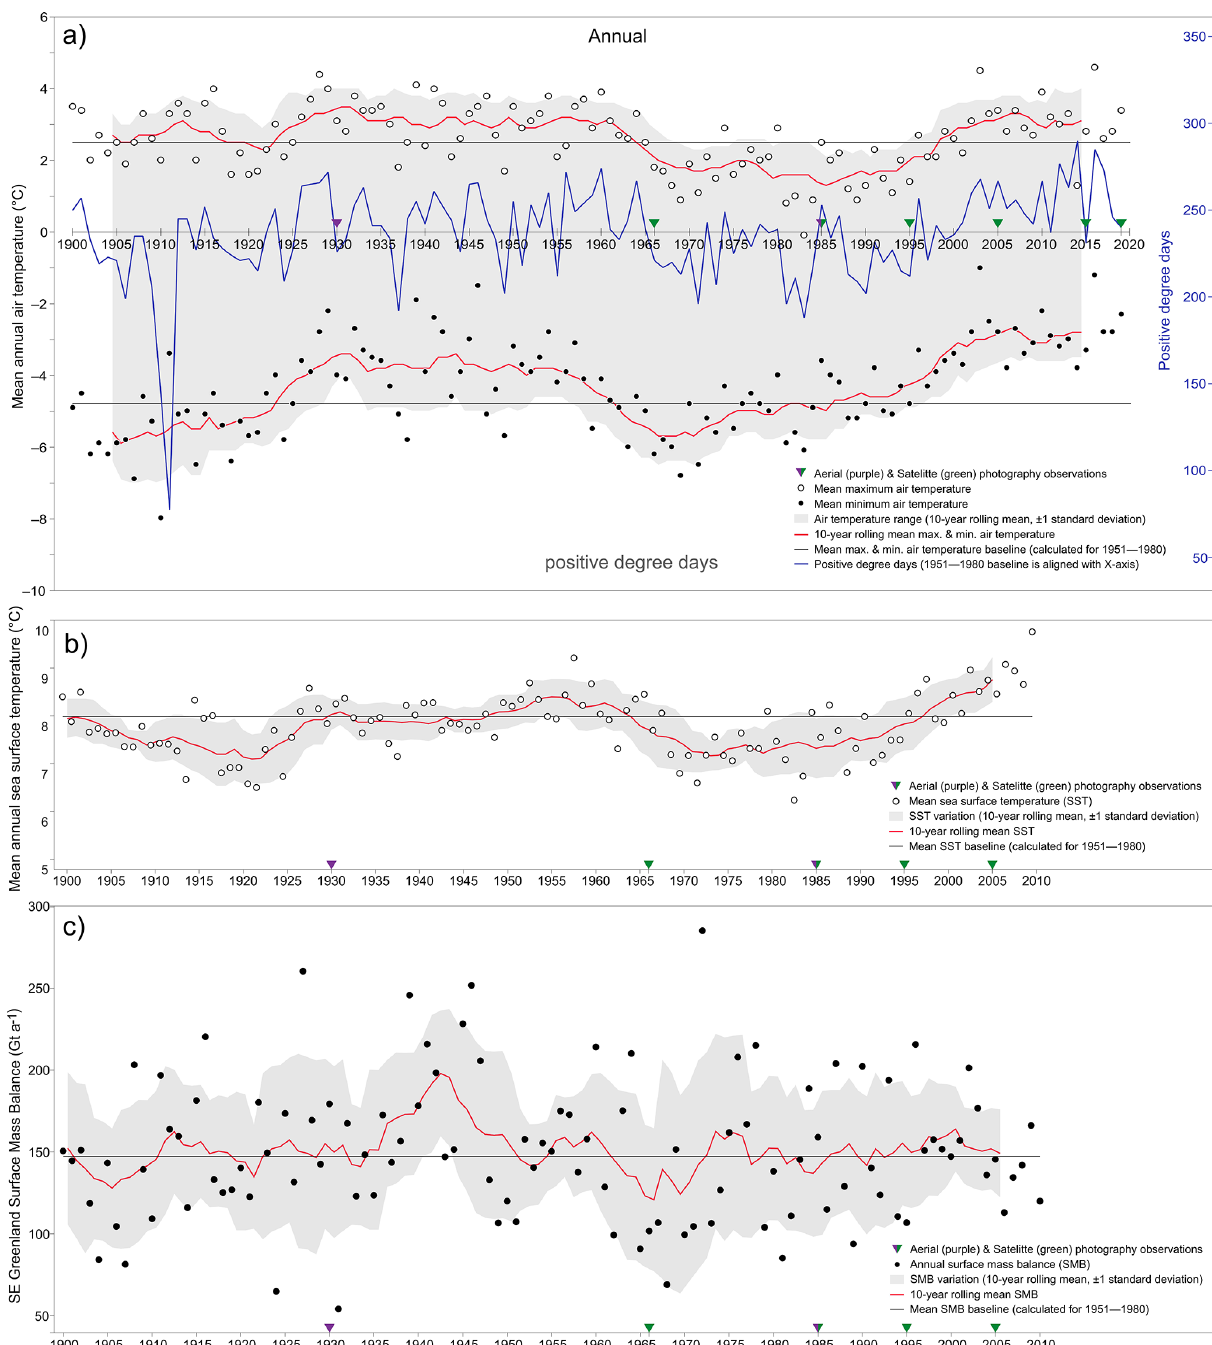
Figure 7. (a) Annual air temperatures from the Tasilaaq meteorological station (data provided by the Danish Meteorological Institute; https://www.dmi.dk/publikationer/, last access: 4 June 2021); (b) Mean annual sea surface temperatures (SST) determined from the Hadley Centre Sea Ice and Sea Surface Temperature data set, taken from the Met Office Marine Data Bank (MDB; https://www.metoffice.gov.uk/ hadobs/hadisst/index.html, last access: 4 June 2021); (c) Surface mass balance (SMB) in South East Greenland for Mittivakkat Gletscher (Mernild et al., 2011). More detailed explanation of each part of this figure is provided in the text.